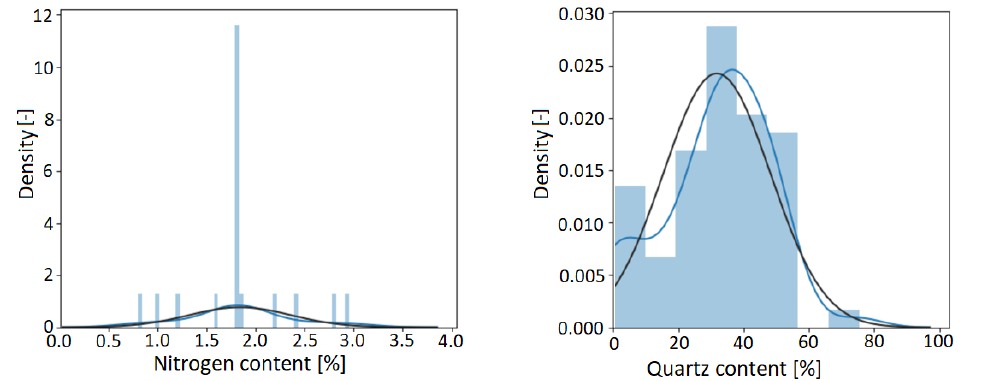
Figure 10. Histogram of the target variables. The left diagram shows the nitrogen content related to lubricants, and the right diagram represents the quartz content of the Exploration and Production laboratory. The black curves show the normal distribution of the given modeling dataset, and the blue is the actual